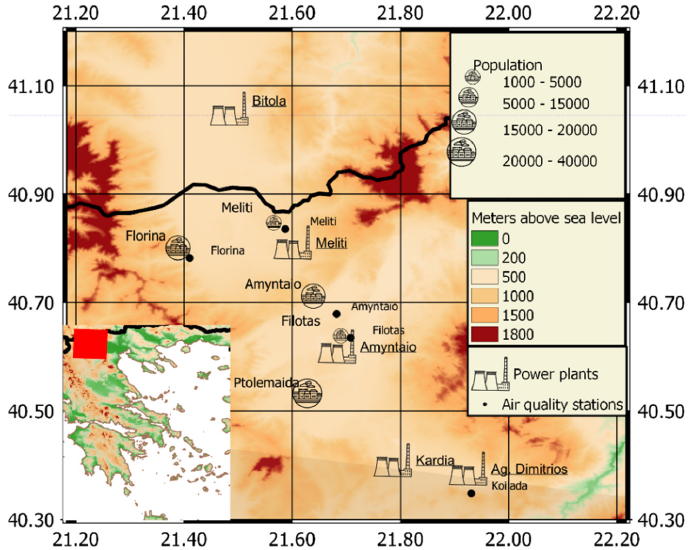
Figure 1. The topography of the target region with the location of the power plants, cities and towns, and air quality stations.